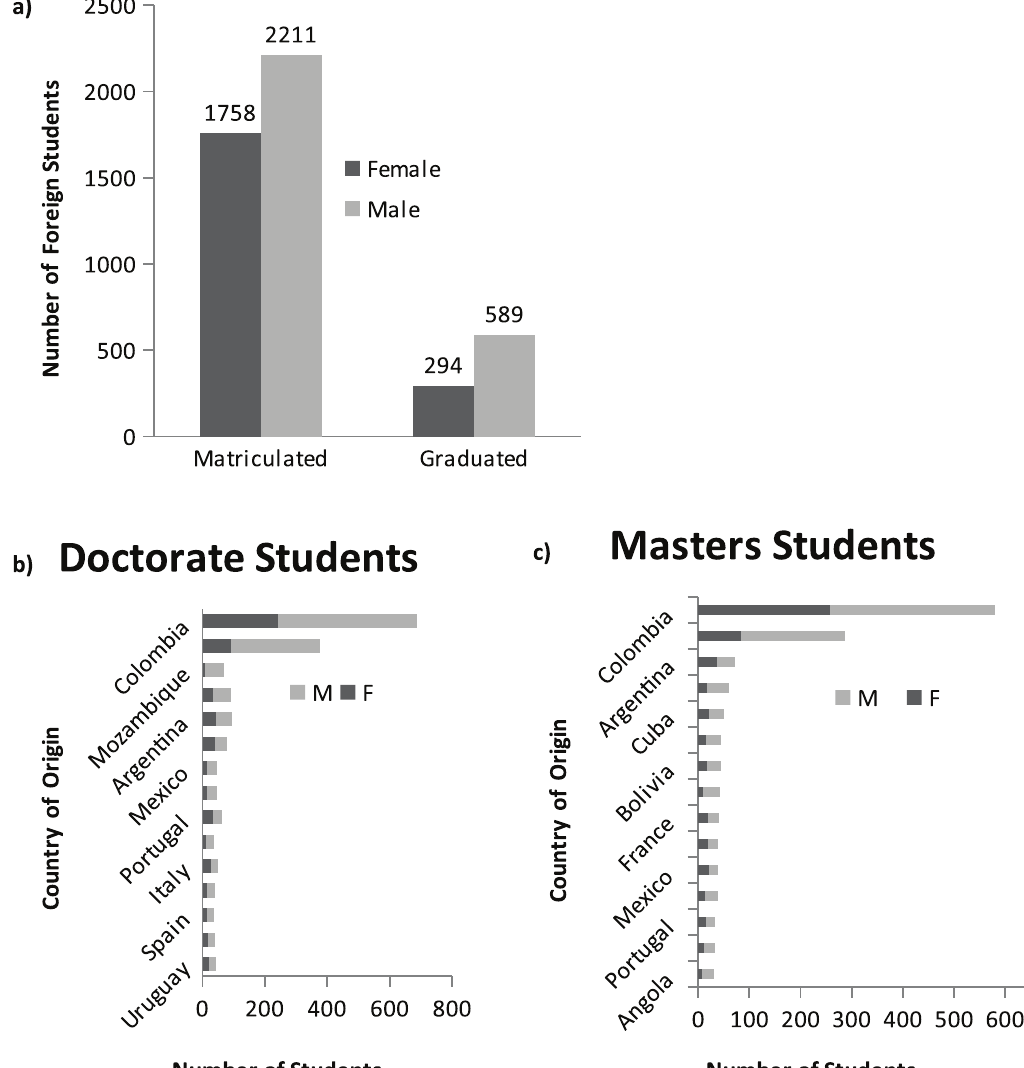
Figure 1 - Foreign students matriculated as well as degrees granted in 2014 (a) by country of origin for doctorate (b) and masters (c) in Brazilian Postgraduate Education. Source: Sucupira